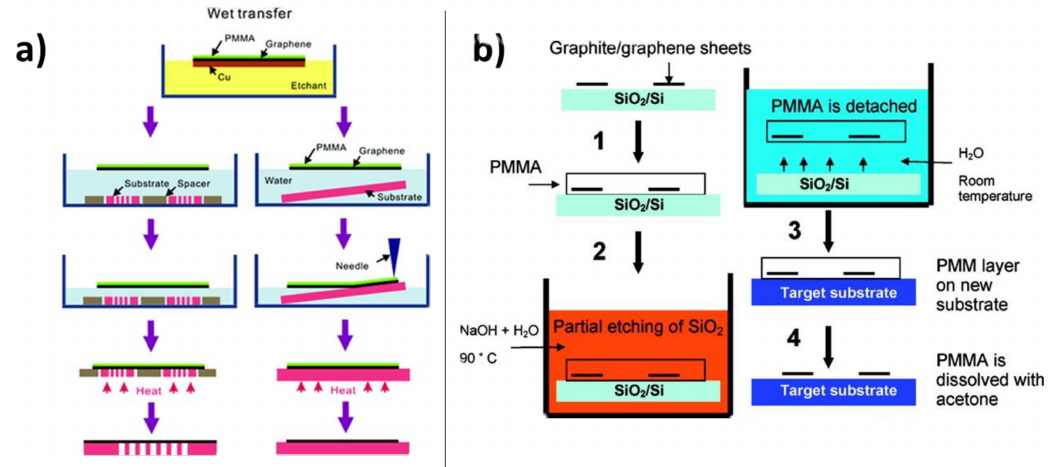
Figure 4. Chemical etching of underlying substrates to facilitate graphene transfer. ( a ) PMMA-assisted transfer of graphene from copper growth substrate. Adapted with permission from Ref. [53]. Copyright 2011 American Chemical Society. ( b ) PMMA-supported transfer with NaOH etching of underlying SiO x substrate. Reprinted with permission from Ref. [56]. Copyright 2008 American Chemical Society.